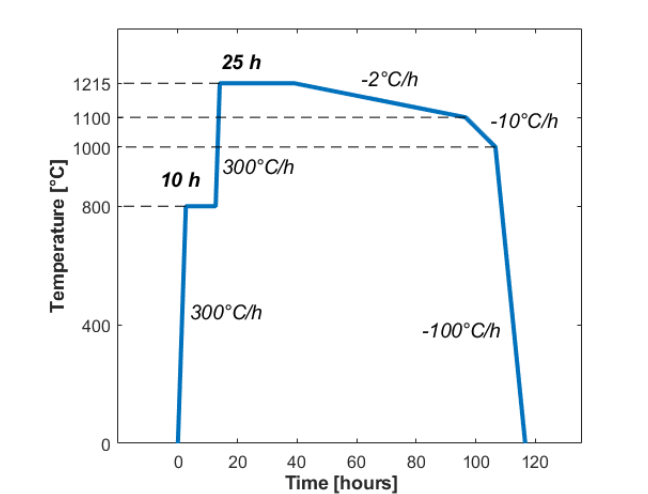
Figure 5. Thermal annealing procedure